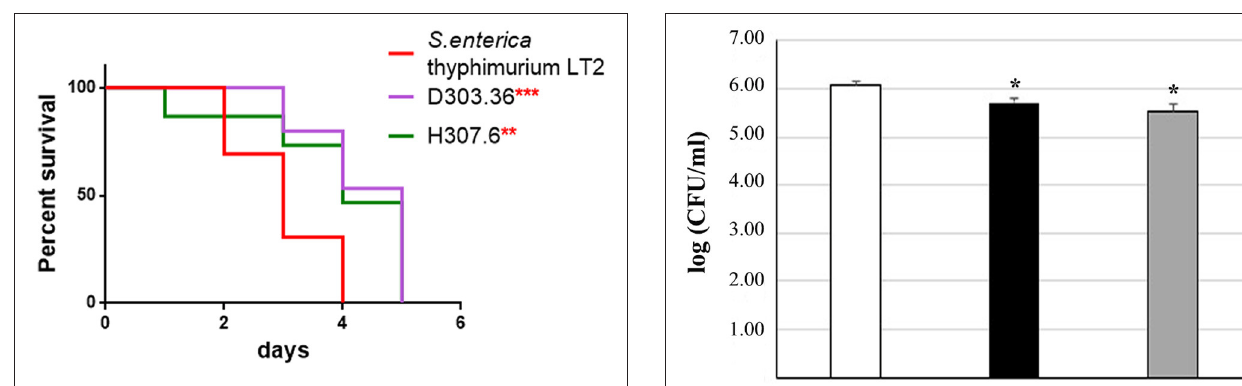
S. enterica serovar Typhimurium, L. monocytogenes and